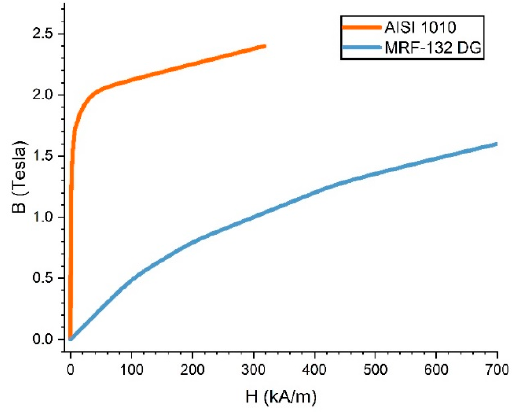
Figure 9. B-H curves of MRF-132 DG [34] and AISI 1010 [33].